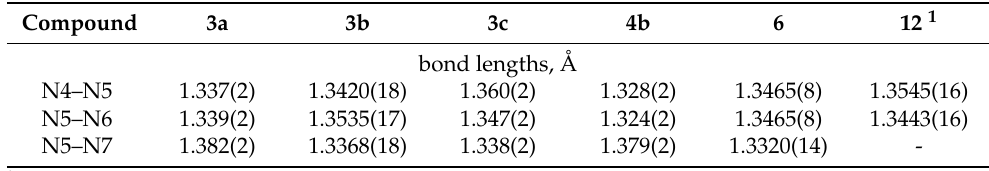
Table 1. Selected bond lengths of compounds 3a – c , 4b , and 6